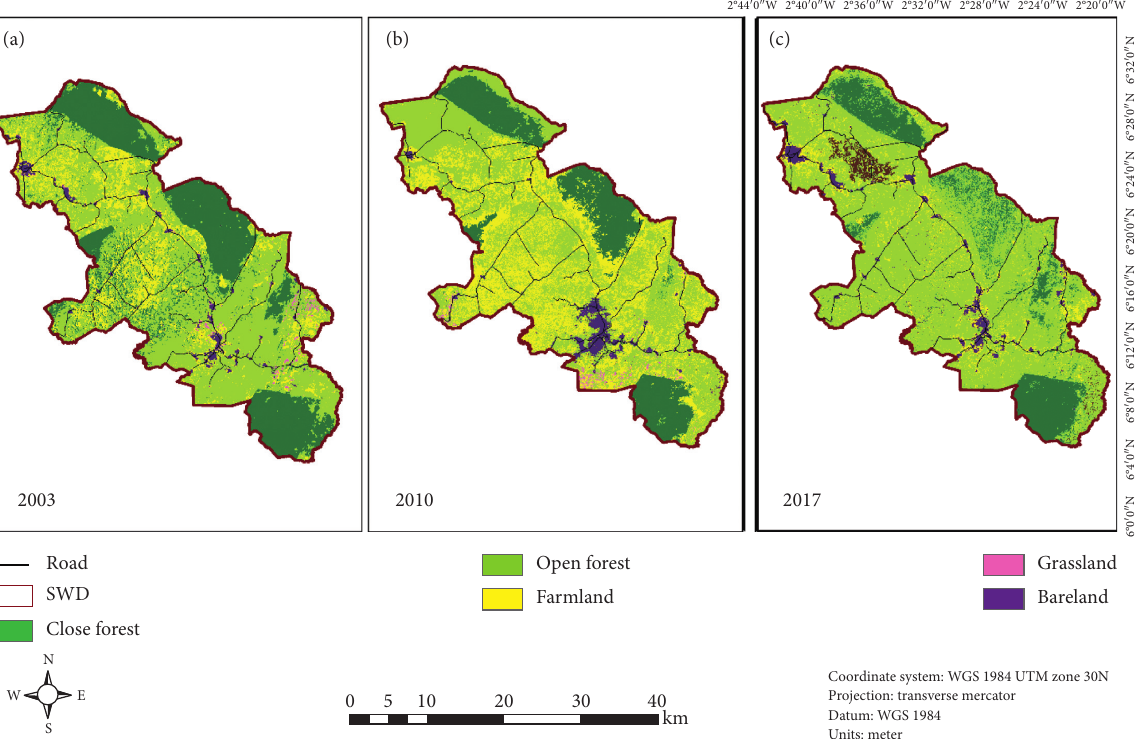
Figure 3: Classified SWD LULC image for (a) 2003; (b) 2010; and (c) 2017. Table 4: Theoretical error matrix for 2017 LULC classification